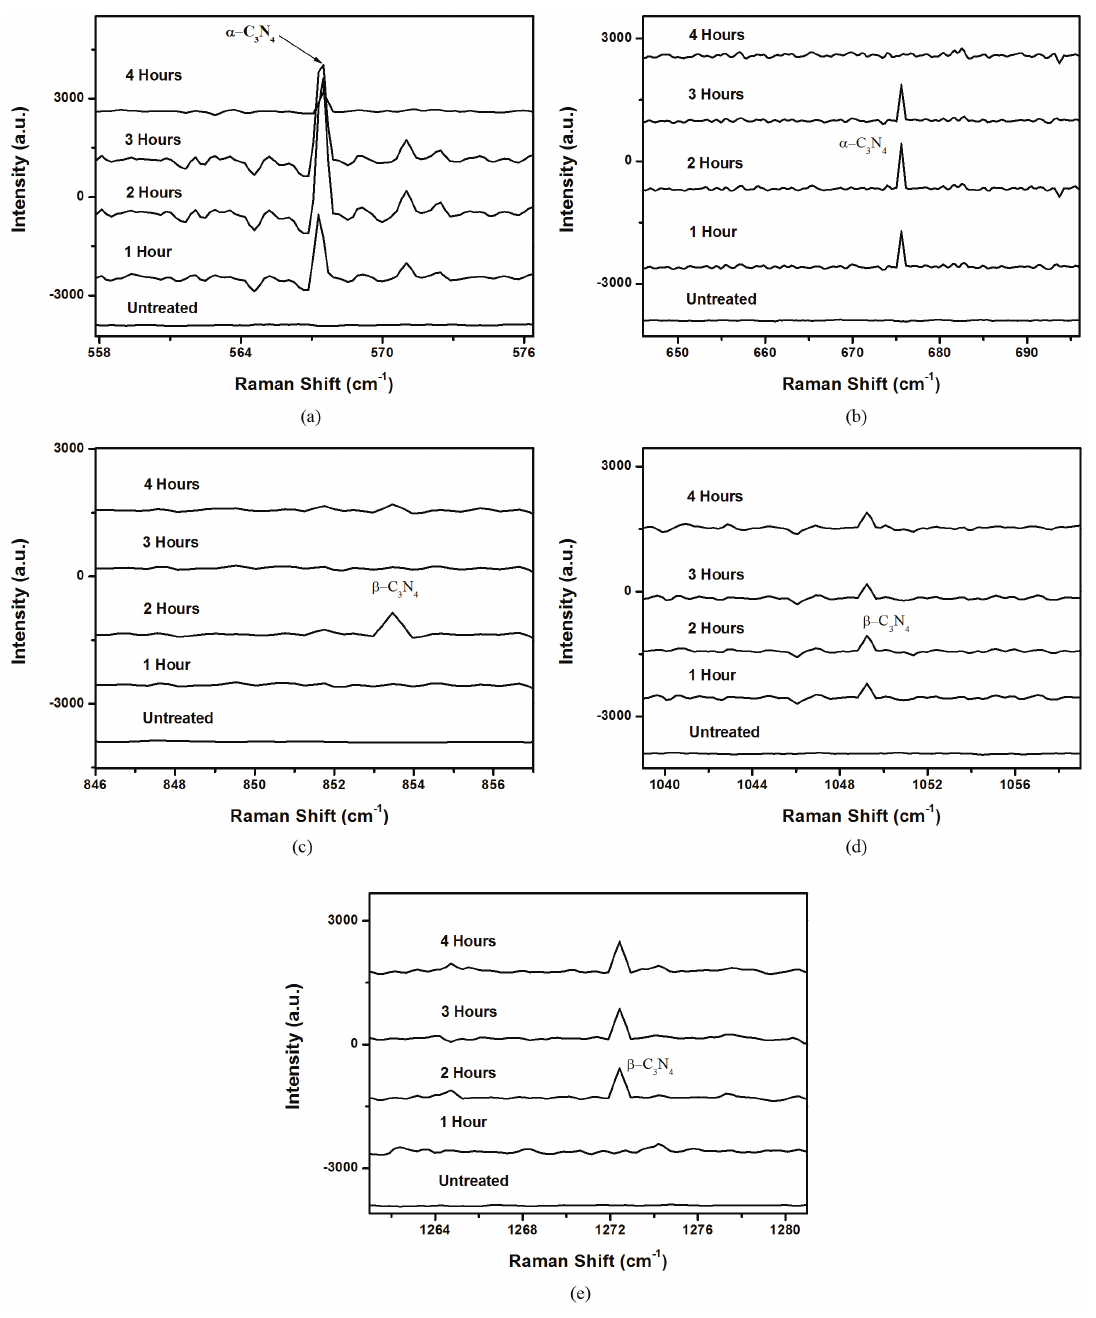
Figure 5. Raman spectra of high carbon steel samples nitrided for different treatment times (1-4 hours) (a) 558-576 cm –1 (b) 646-696 cm –1 (c) 846-857 cm –1 (d) 1039-1059 cm –1 (e) 1261-1281 cm –1 .